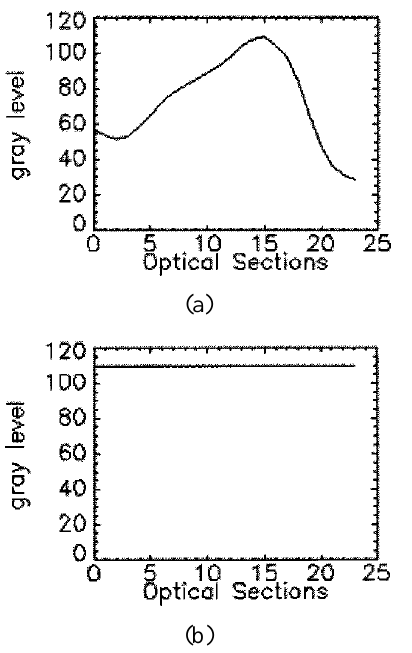
Fig. 2. Plot of average intensity of the foreground vs depth of the specimen. (a) Before intensity restoration, (b) after intensity restora- tion.